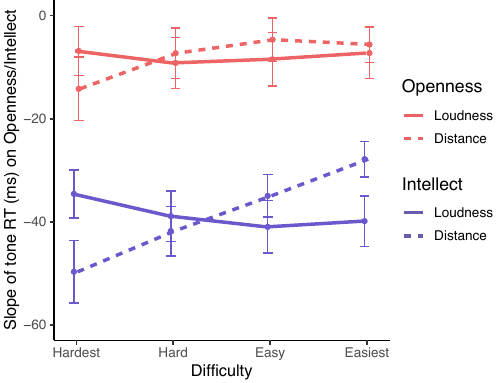
Figure 1. Regression coefficients of RT (ms) on the BFAS Intellect (bottom lines) and Openness aspects (top lines) across levels of difficulty for both tone loudness and frequency distance manipulations in the tone comparison task. Aspect scores represent standard scores. Error bars represent ± 1 standard error of the sample